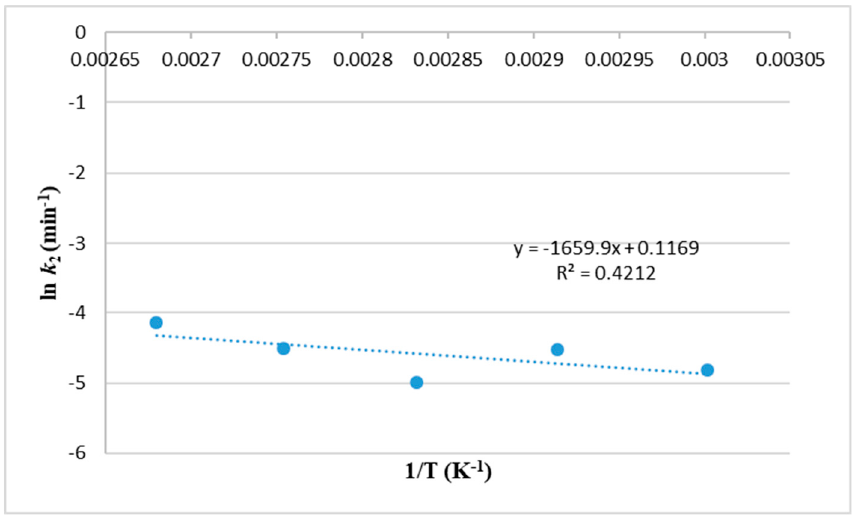
Figure 3. Relationship between temperature and the second-order extraction rate coefficient, ln k 2 , for extraction of lipids from Nannochloropsis sp . microalgae using MAE-brine.